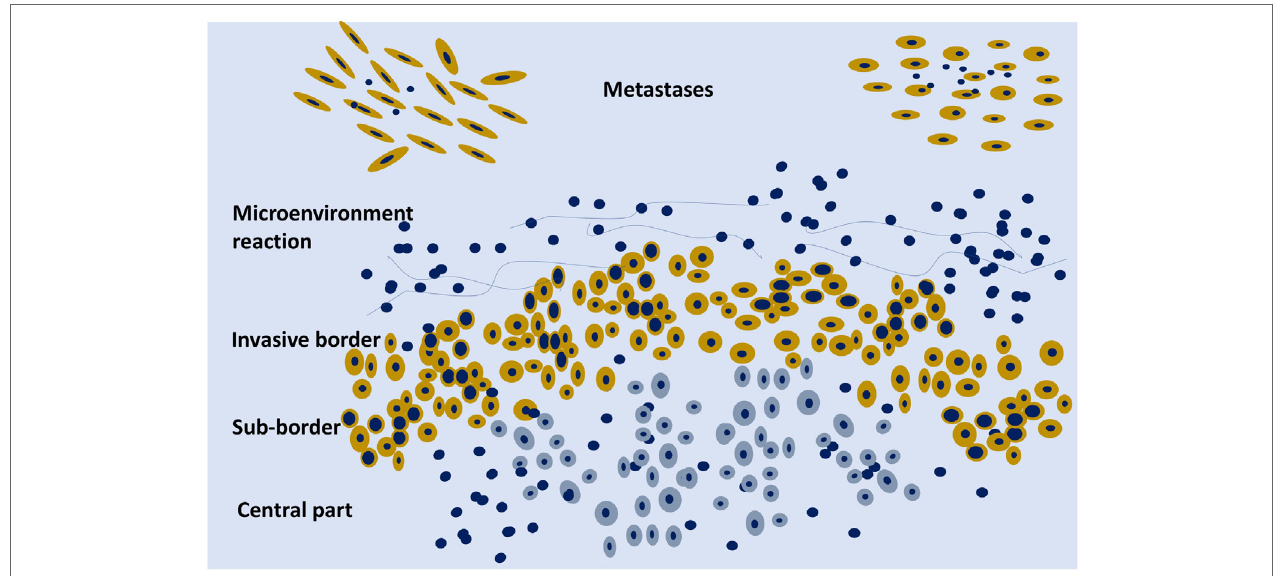
FiGURe 2 | Schematic representation of an organoid tumor with peripheral cells (yellow) surrounded by stroma components and phenotypically different from the central cells (gray). On the upper part, two metastases are schematically